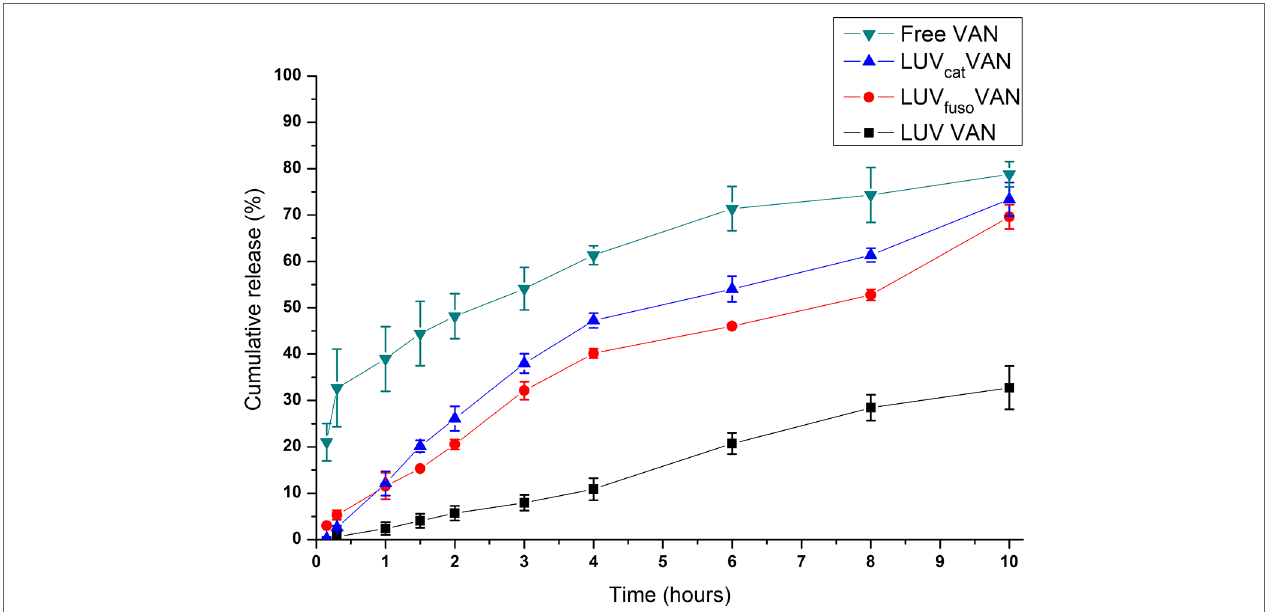
FIgUre 3 | In vitro release kinetics of VAN in solution and encapsulated in the liposomal formulations, at 37°C. Two-way ANOVA, Tukey, P < 0.05. There were statistical difference between groups, as follows: LUV VAN × LUV fuso VAN—from 1 to 10 h; LUV VAN × LUV cat VAN—from 1 to 10h; LUV VAN × free VAN—from 0.15 to 10 h; LUV fuso VAN × free VAN—from 0.15 to 8 h; LUVcat VAN × free VAN—from 0.15 to 8 h.